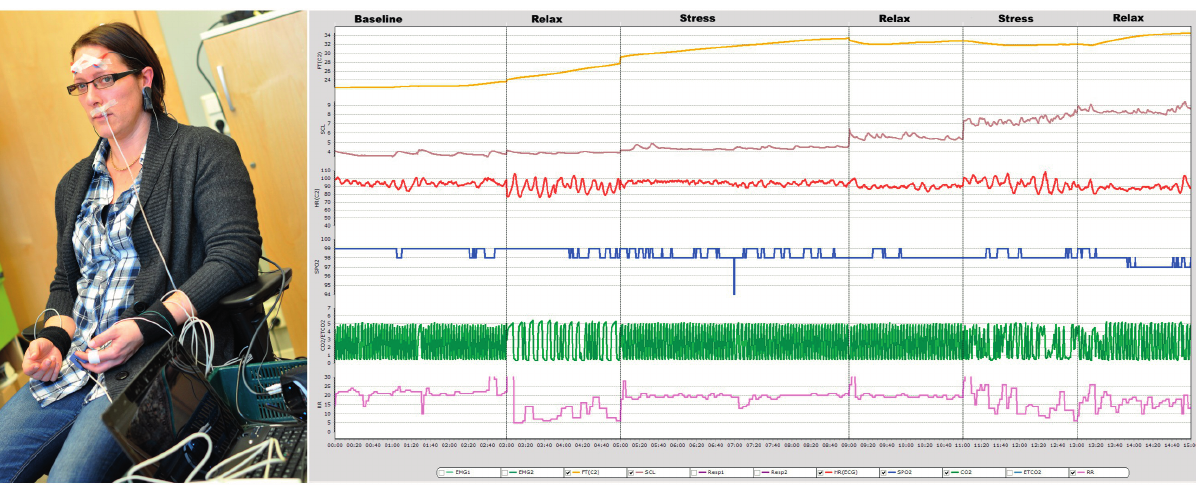
Figure 1. Experimental setup and five physiological signals during the physiological data